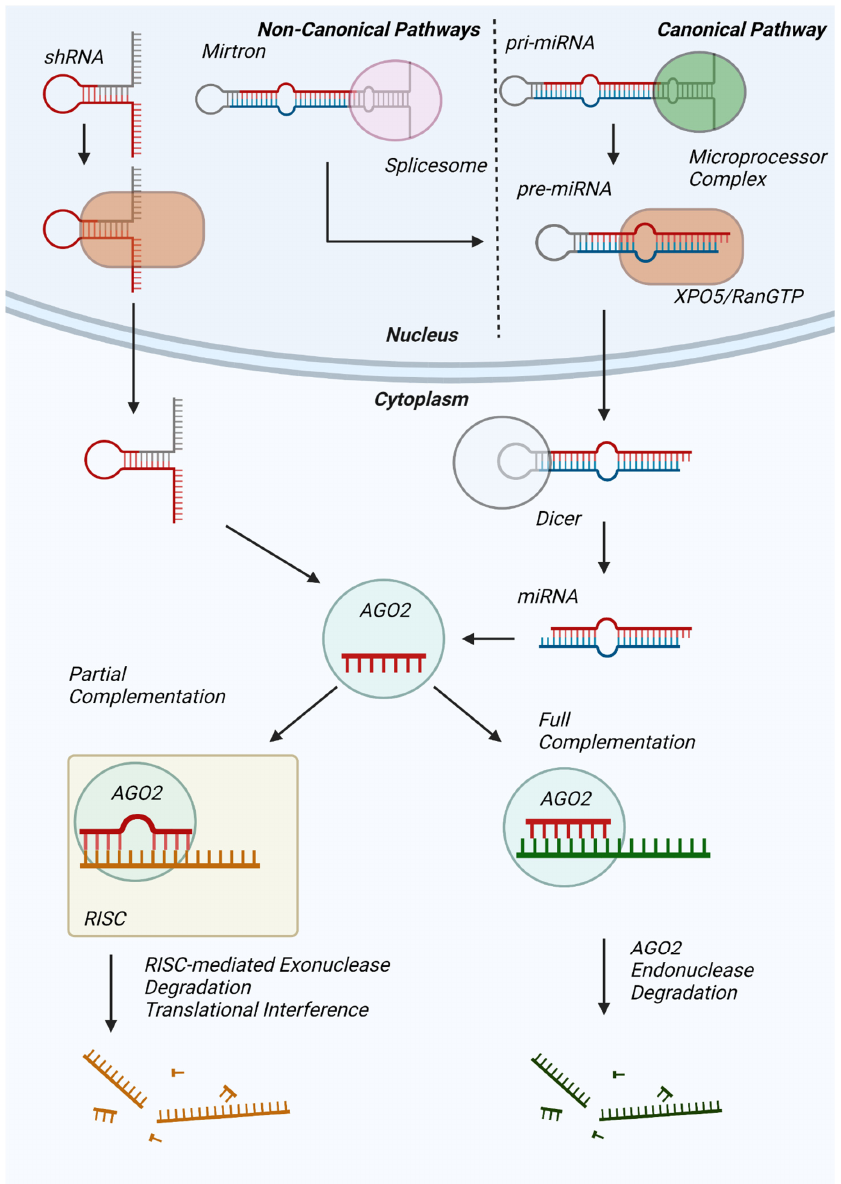
Figure 1. Overview of miRNA synthesis, maturation, and mRNA degradation. Pri-miRNAs tran- scribed by RNA Polymerase II (canonical) or Mirtrons produced by the spliceosome (non-canonical) are processed by the Drosha/DGCR8 microprocessor complex into pre-miRNAs for subsequent XPO5/RanGTP complex-mediated export. Cytosolic Dicer further processes pre-miRNA into mature miRNA for subsequent Ago2 binding. shRNA (non-canonical) can be exported from the nucleus via XPO5-RanGTP and be incorporated directly into Ago2. The Ago2-miRNA complex targets mRNA for degradation either via Ago2 endonuclease activity (full complementarity) or recruitment of additional proteins for RISC-mediated mRNA degradation or translational